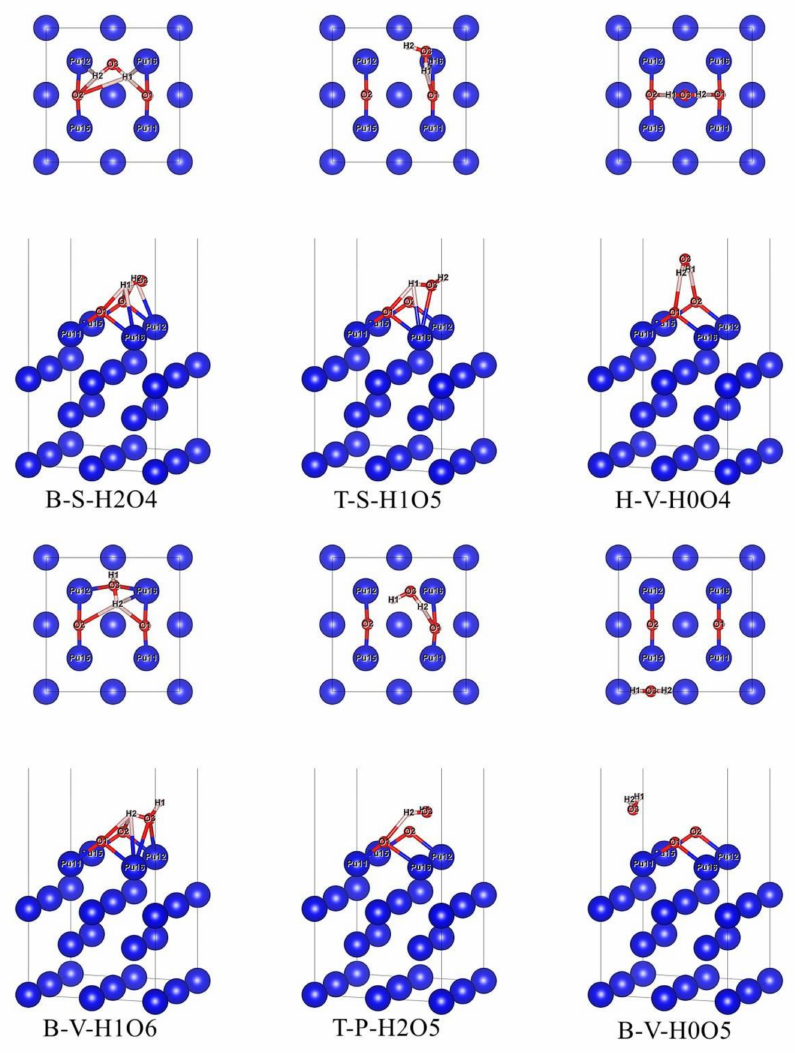
Figure 5. Stable co-adsorption configuration based on the most stable adsorption configuration of O 2 single